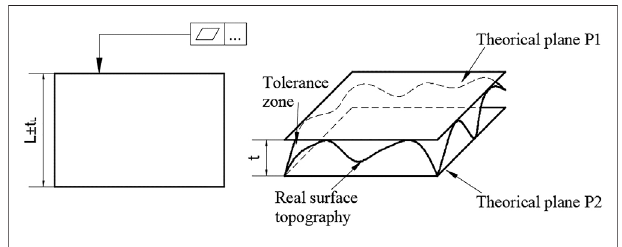
FIGURE 1 | Flatness error